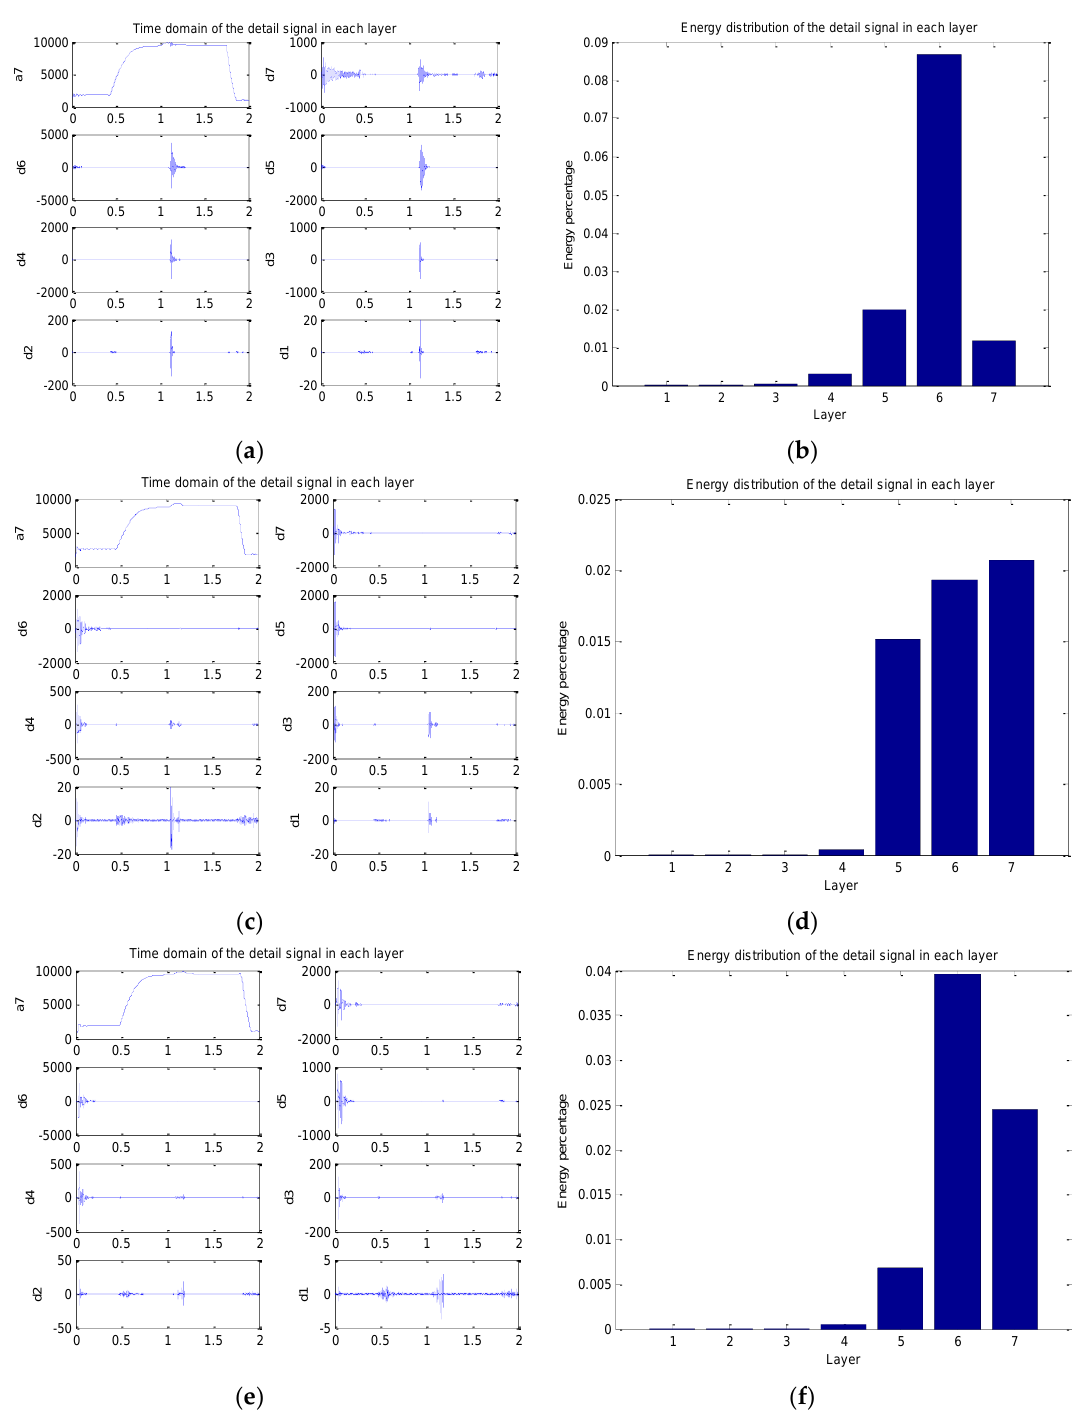
Figure 7. ( a ) Time domain of the expulsion signal in each layer; ( b ) energy distribution proportion of expulsion signal in each layer; ( c ) time domain of other signal 1 in each layer; ( d ) energy distribution proportion of other signal 1 in each layer; ( e ) time domain of other signal 2 in each layer; ( f ) energy distribution proportion of other signal 2 in each layer.